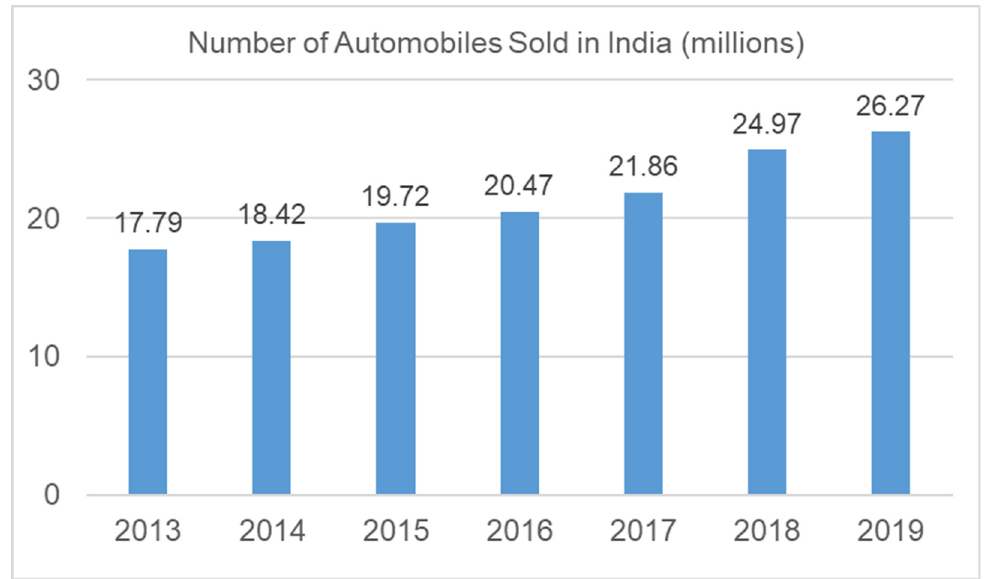
Figure 2. Number of Automobiles Sold in India from 2013 to 2019.